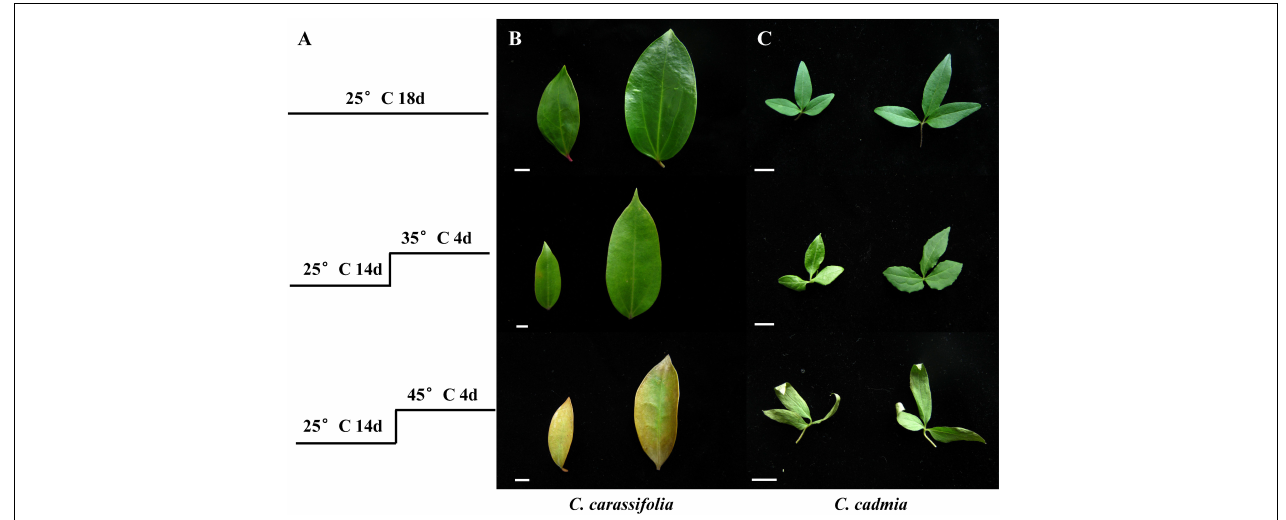
FIGURE 1 | Effect of heat stress on the morphology of the leaves of C. crassifolia and C. cadmia . (A) Treatment conditions. (B) The phenotype of C. crassifolia leaves. (C) The phenotype of C. cadmia leaves. Bar means 1 cm.